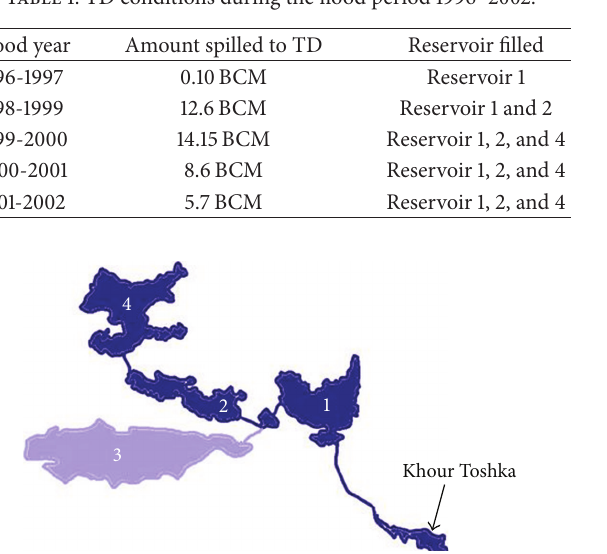
The sills between the subdepressions have changed in form and elevation due to water flushing from the Toshka canal to the first subdepression (Basin 1) and subsequently from it to the second and fourth subdepressions. These changeable sills’ elevations affected the filling sequence of the TD basins.